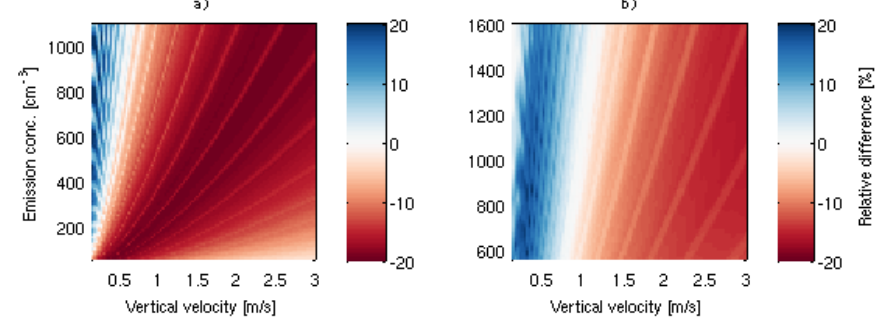
Figure 5: Relative difference of the ACI parameter between the reallocating and unrestricted modal models in experiment 1. a) shows the difference without and b) with background aerosol.